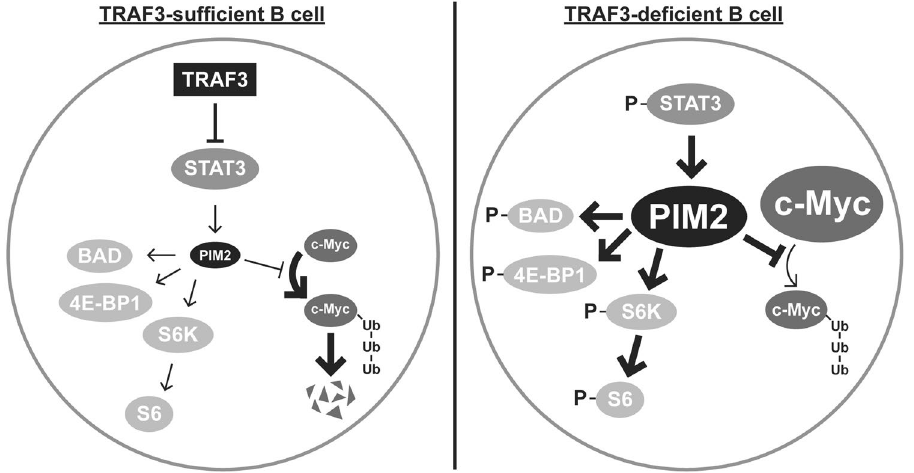
Figure 7. Model of Pim2 regulation in TRAF3-sufficient and –deficient B cells. In TRAF3-sufficient cells, TRAF3 inhibits STAT3 phosphorylation, resulting in decreased Pim2 protein. In the absence of TRAF3, there is increased STAT3 phosphorylation and Pim2 protein resulting in stabilization of c-Myc protein, and increased phosphorylation of the Pim2 targets BAD, p70S6K, 4E-BP1, and